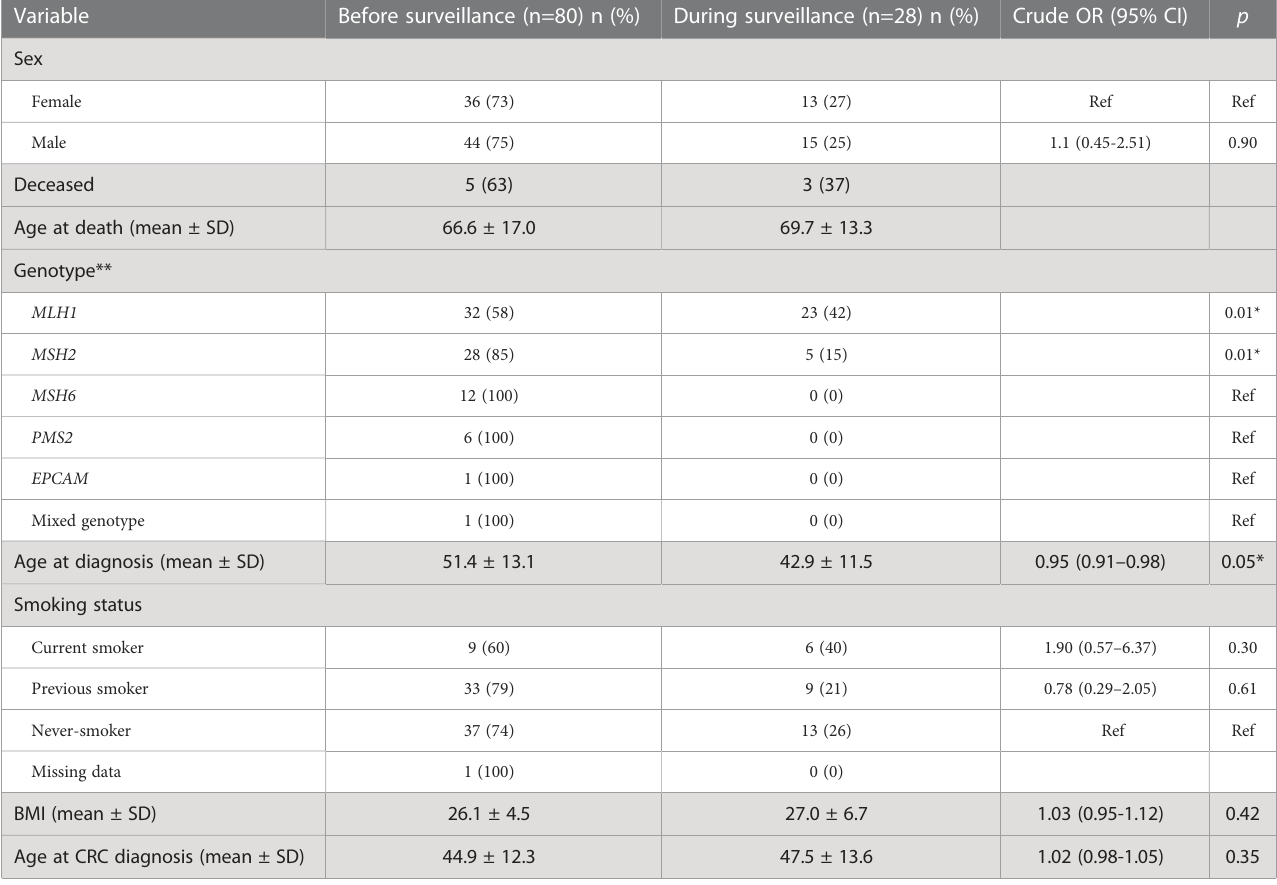
TABLE 3A Univariable logistic regression and Fisher ’ s exact test on patient characteristics of CRC cohort before and during surveillance.